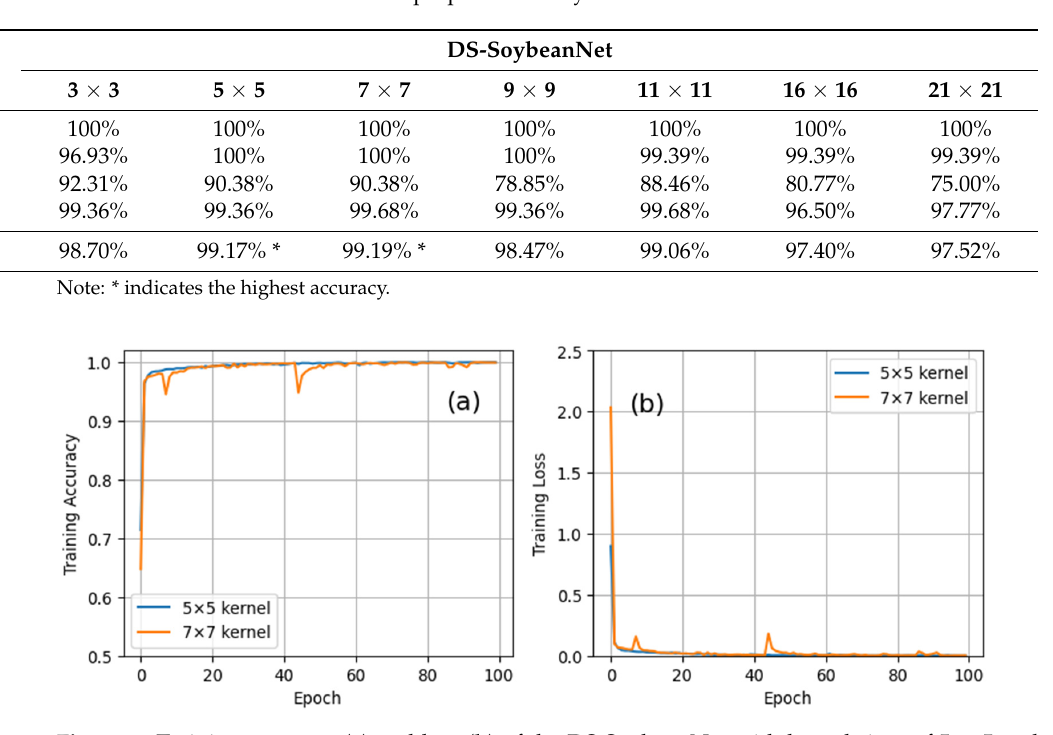
Figure 5. Training accuracy ( a ) and loss ( b ) of the DS-SoybeanNet with kernel sizes of 5 × 5 and 7 × 7.